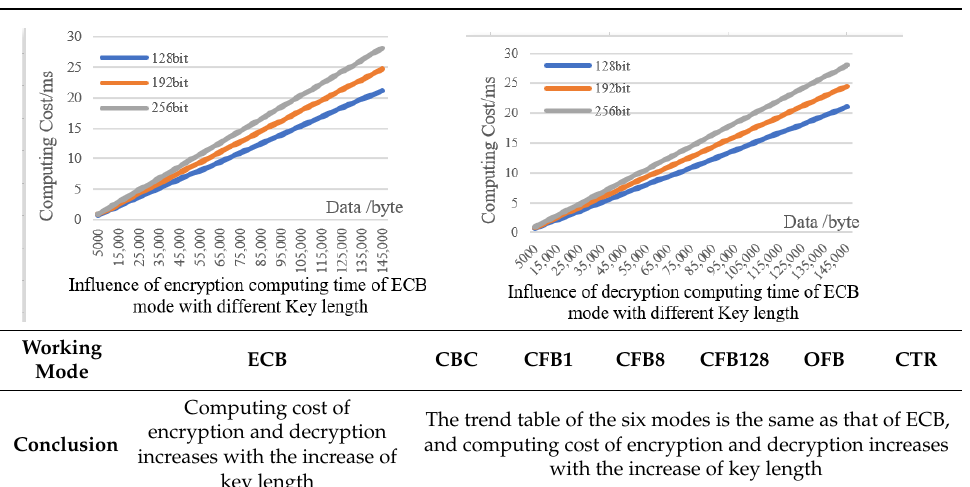
Table 1. Computing cost analysis and comparison of AES encryption and decryption.